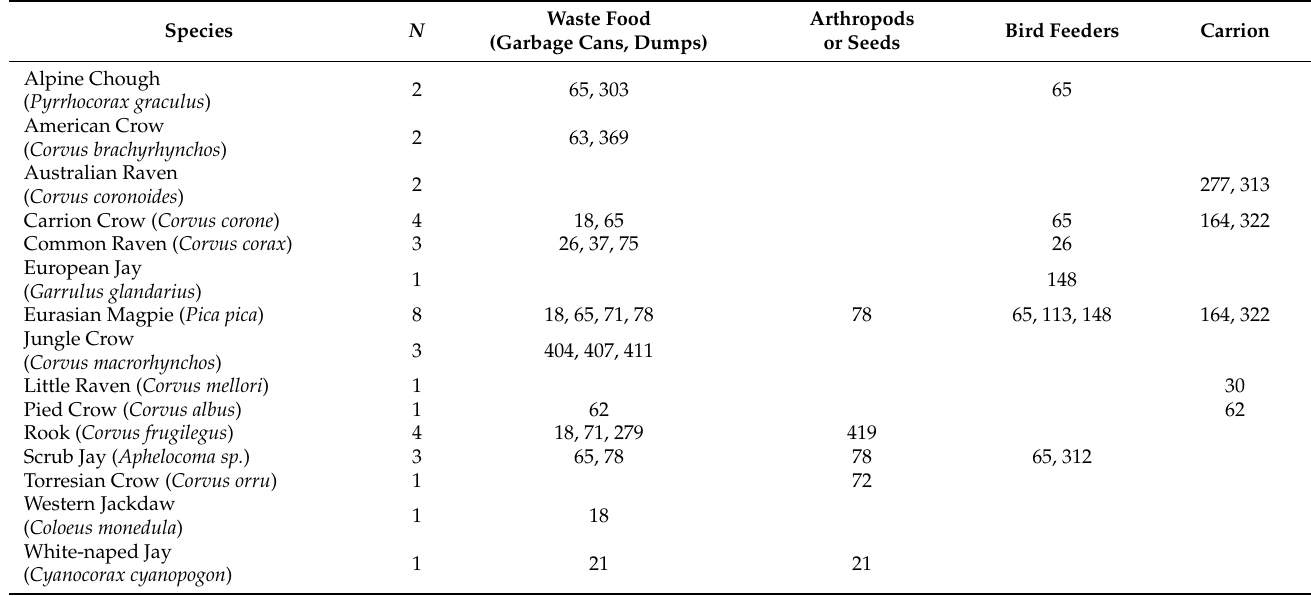
Table 3. List of articles in relation to artifical food resource use of corvids in urban environments ( n = 28). The reference numbers in the table refer to the individual publication numbers given in Table S2.